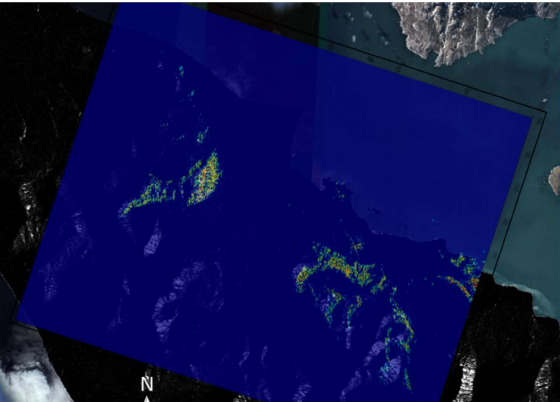
Figure 19. Overlay between the MF-PB-SAR image obtained in Spitsbergen and the SAR image generated by